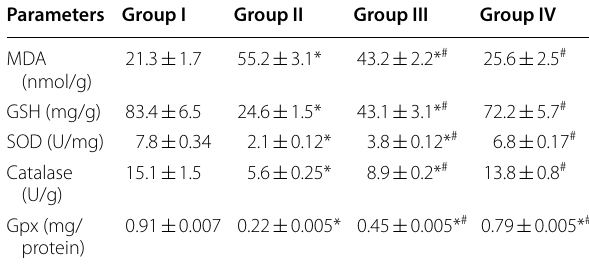
* P < 0.05 vs. group I #